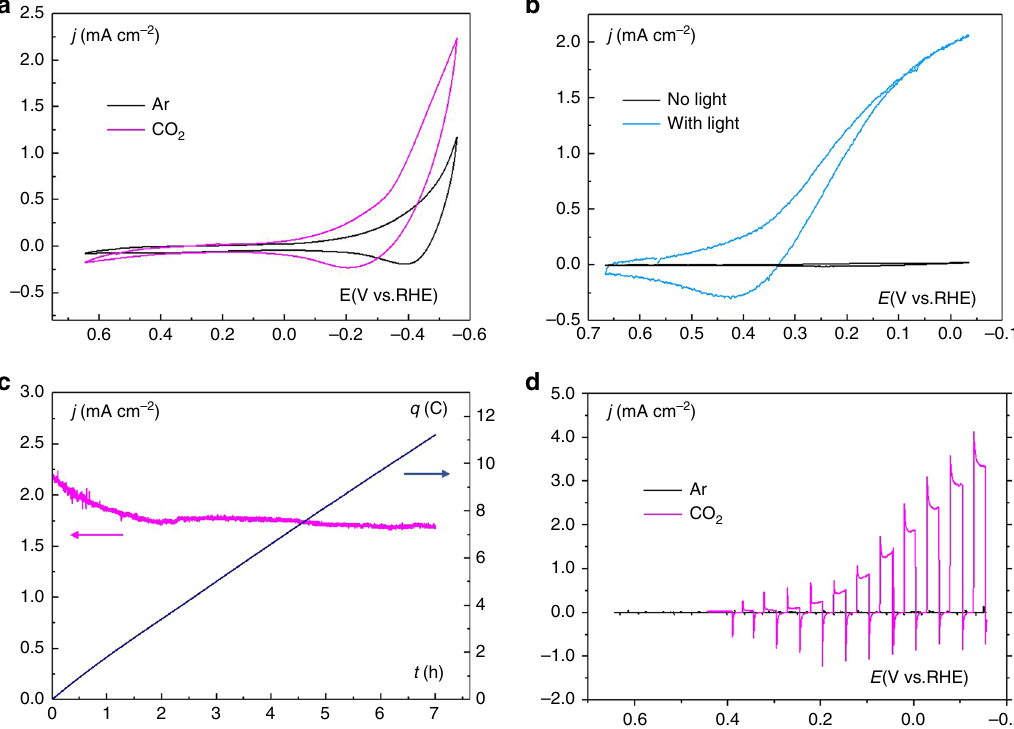
Fig. 4 Electrochemical and photoelectrochemical data in various con fi gurations. a CV in EC conditions at a Co-qPyH | m-TiO 2 electrode in 0.1 M KHCO 3 , saturated with argon (black) or CO 2 (magenta). Scan rate was 20 mV s − 1 . b CV in PV + EC conditions at a Co-qPyH | m-TiO 2 electrode in 0.1 M KHCO 3 saturated with CO 2 , connected to CIGS solar cells without (black) and with light illumination (blue). Scan rate was 20 mV s − 1 . c Long-term electrolysis in PV + EC conditions at a Co-qPyH | m-TiO 2 electrode in 0.5 M KHCO 3 saturated with CO 2 (pH 7.2), connected to an external irradiated CIGS solar cells polarized at − 0.03 V vs. RHE with continuous bubbling during electrolysis. d LSV in PEC conditions at a Co-qPyH | f-TiO 2 | CIGS electrode in 0.1 M phosphate buffer saturated with argon (pH 6.8, black) or 0.1 M KHCO 3 electrolyte saturated with CO 2 (pH 6.8, magenta) under chopped light irradiation. Scan rate was 5 mV s − 1